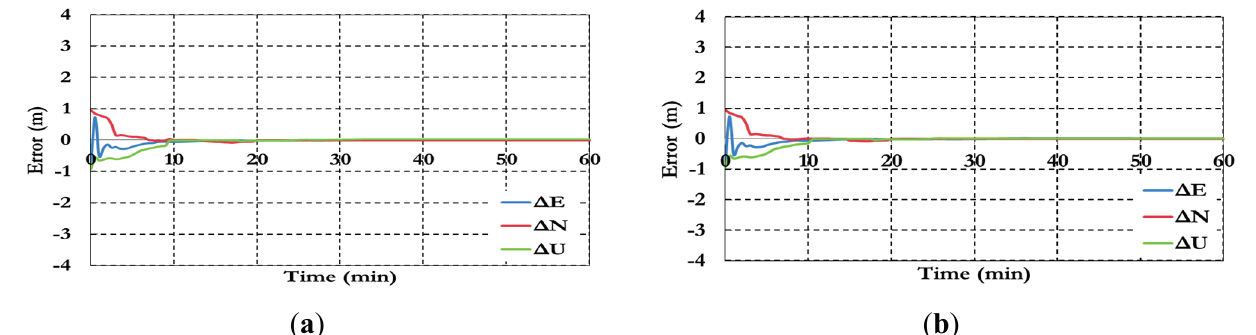
Figure 20. Positioning results for BSSD semi-decoupled GPS/Galileo PPP model. ( a ) GPS reference satellite; and ( b ) Galileo reference